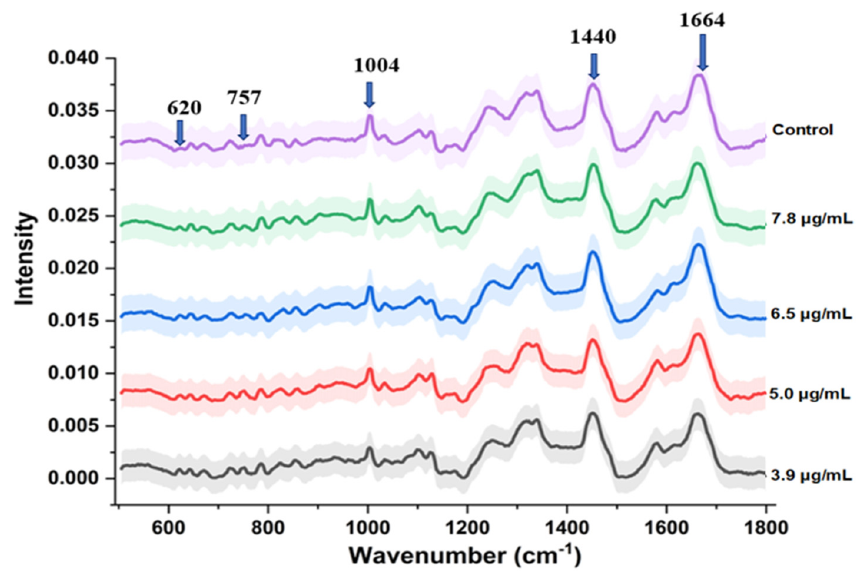
Figure 4. Average Raman spectra from colistin sensitive and resistant bacterial cells collected from the log phase. The shaded area represents the standard deviation. Characteristic spectral bands are marked with an arrow.